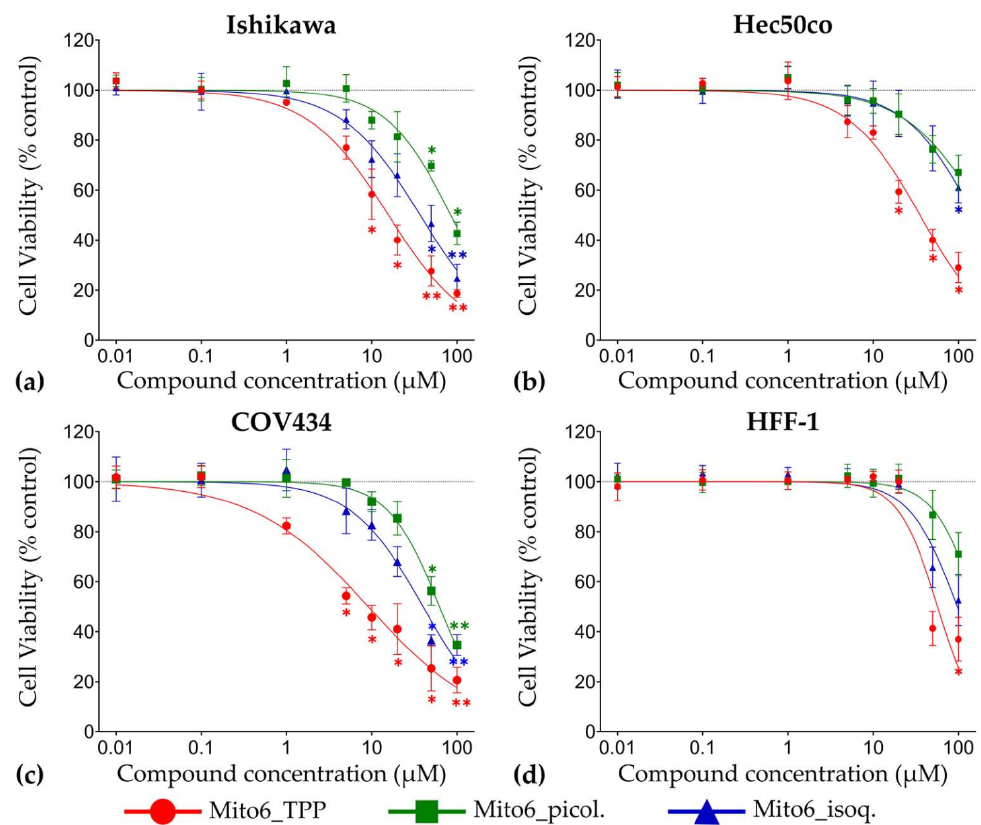
Figure 4. Viability assessed by the Neutral Red (NR) assay of Ishikawa ( a ), Hec50co ( b ), COV434 ( c ), and HFF-1 ( d ) cells treated with Mito6_TPP, Mito6_picol., or Mito6_isoq. (0.01–100 µ M) at 48 h of incubation. Untreated cells containing only the respective cell medium and 2% FBS were used as control and are represented as a dotted line at 100%. Results are compared to the control and expressed as mean ± SEM of at least three independent experiments performed in triplicate. Significant differences between treated and untreated cells are described as * ( p < 0.05) and ** ( p <